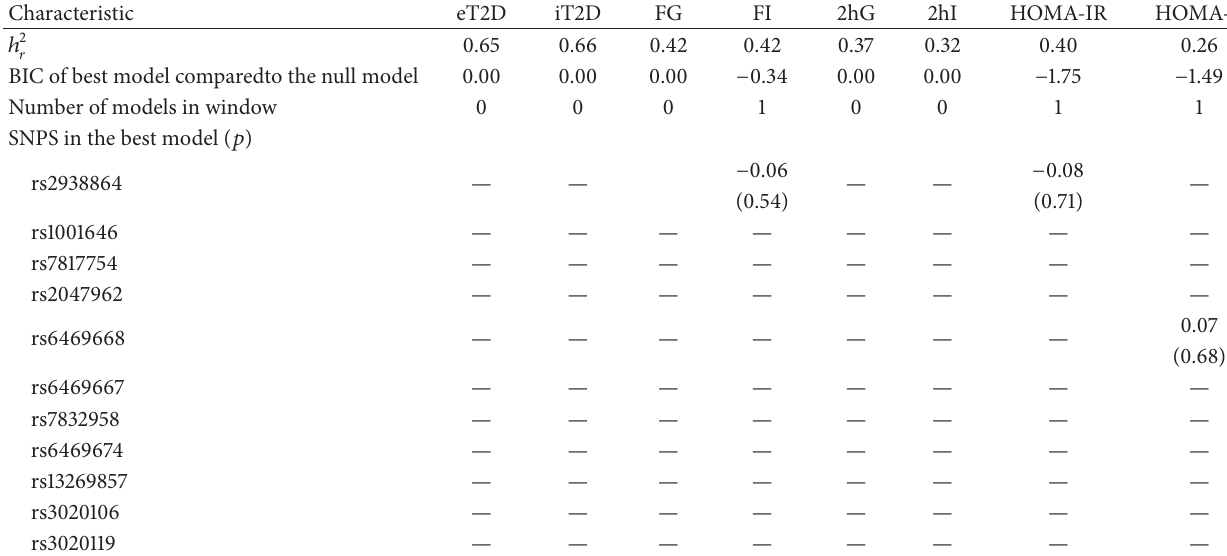
Table 3: Results of BQTN analyses for potential combinatorial associations of SLC30A8-related SNPS with T2D-related traits. Characteristic BIC of best model comparedto the null model Number of models in